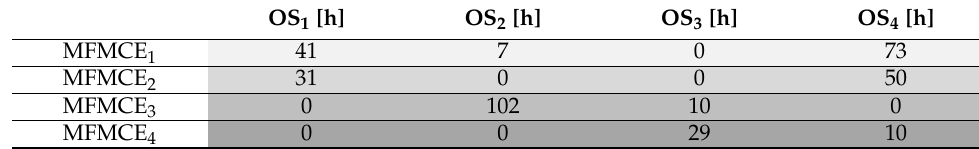
Table 7. Cross combination with all zero lines